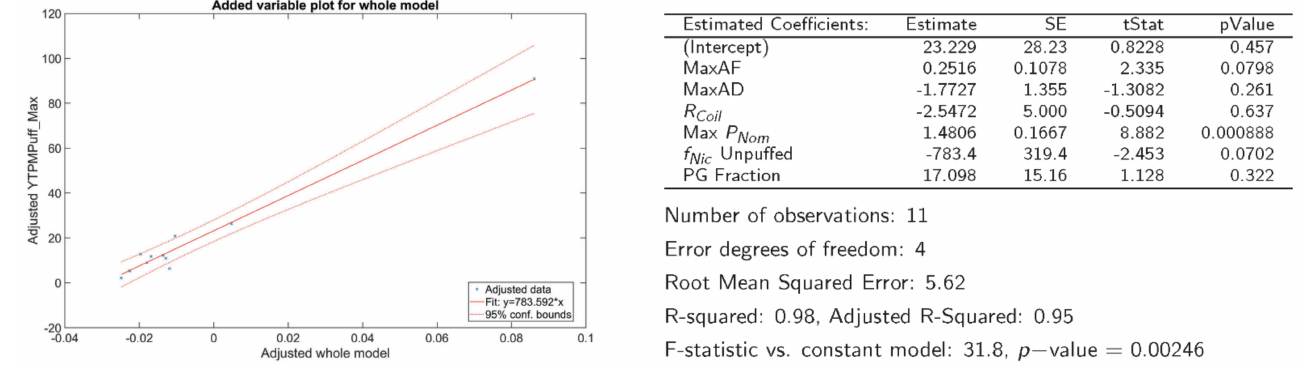
Figure 9. Assessing potential associations between Max ˆ Y TPM and the product characteristics of f Nic , f PG , R Coil , Max P Nom , MaxAF, and